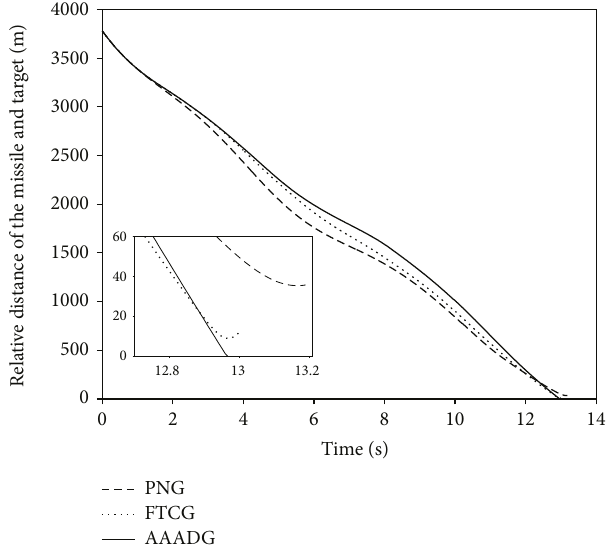
Figure 5: Relative distances between the interceptor and target under three guidance laws.